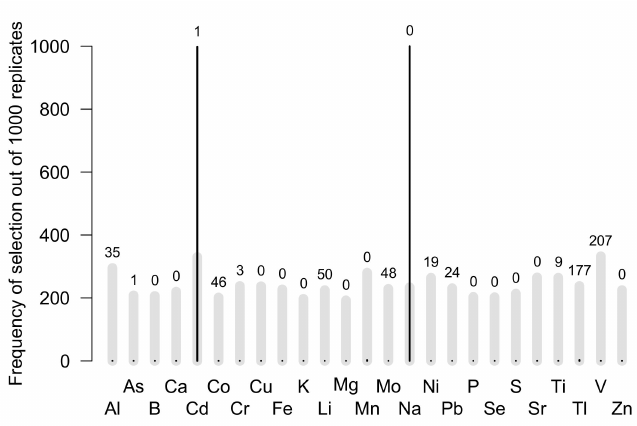
Figure 5. Frequency of selection for each of the 25 analyzed elements (in abscise) out of 1000 replicates in a generalized linear model linking alive status with the concentration of the elements. Unquantifiable (UnQ) values are replaced with a posterior predictive random value in replicates. Model selection was performed using AICc (i.e., Akaike information criterion with a small sample correction). Black lines correspond to the number of times the element is selected, and gray lines are the same when data are shuffled (false positive). The number at the top of each bar is the number of